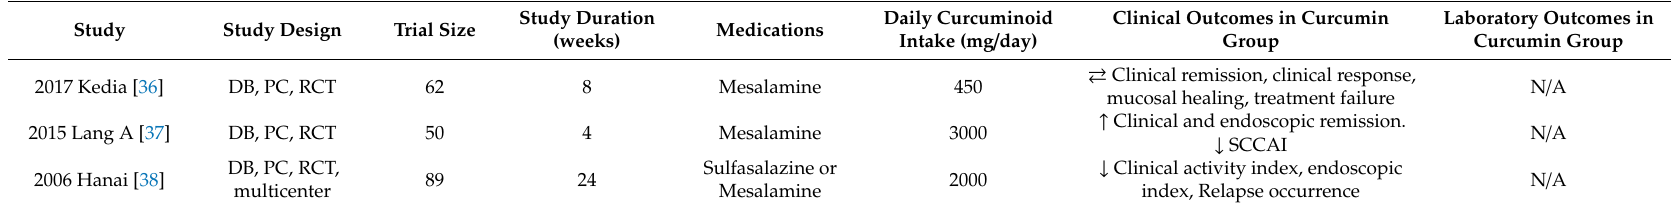
Table 3. Clinical e ffi cacy of curcumin supplementation in ulcerative colitis